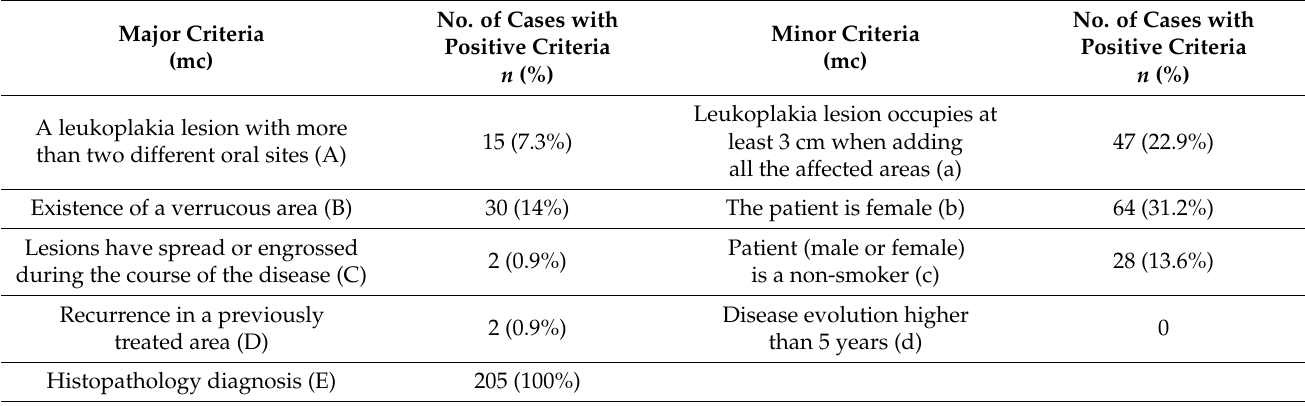
Table 4. Patients with positive